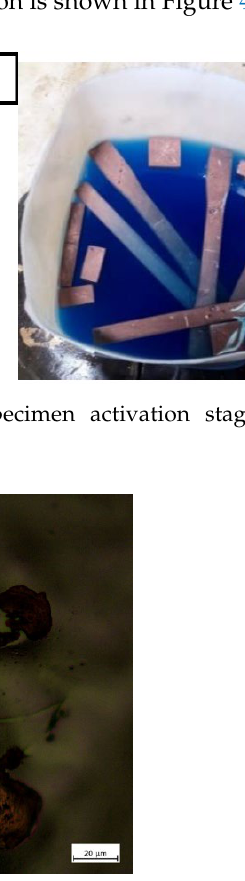
Figure 2. ( a – c ) show pure PETG 3D-printed samples based on the ASTM standards; ( d ) twin screw extrusion of the 3D printing of the PETG filament; ( e ) 3D printing of the PETG+MWCNT tensile specimen; ( f ) final printed PETG+MWCNT specimen.